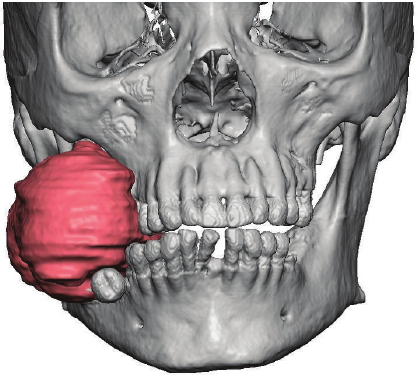
Figure 1: Computer simulation of patient with a large swelling on the lower right side of his